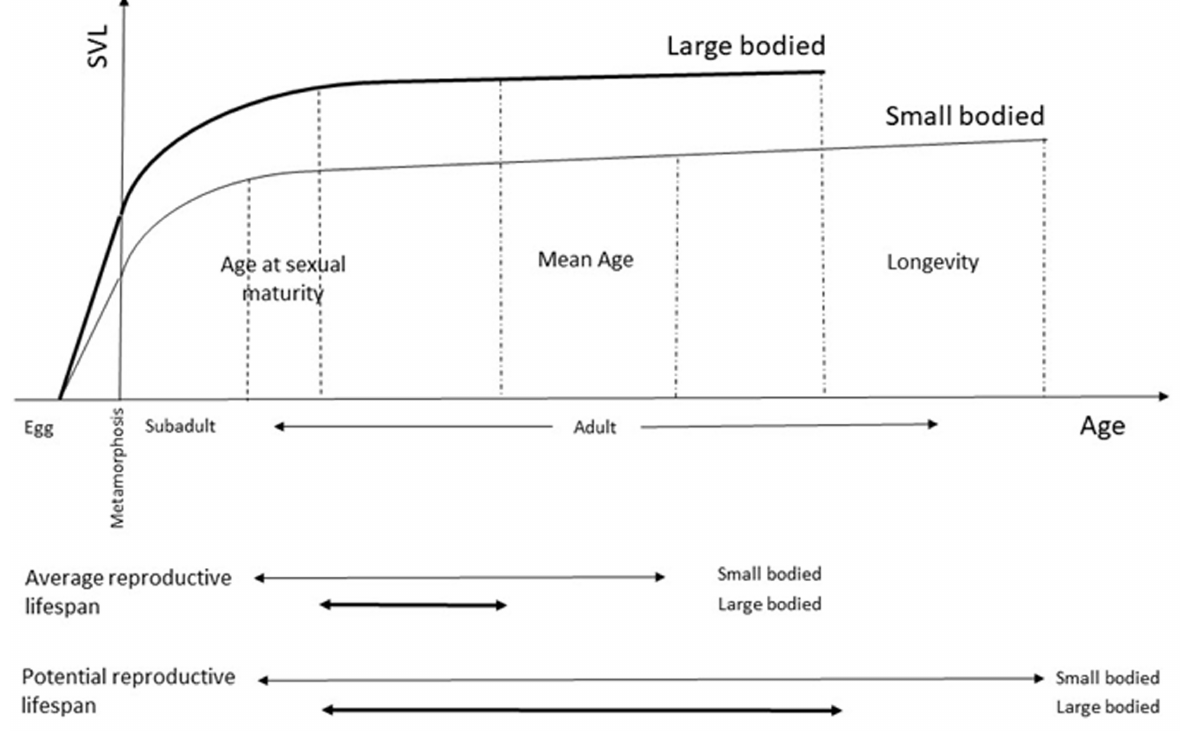
Figure 6. A schematic comparison of size and age-related parameters in Large and Small-Bodied